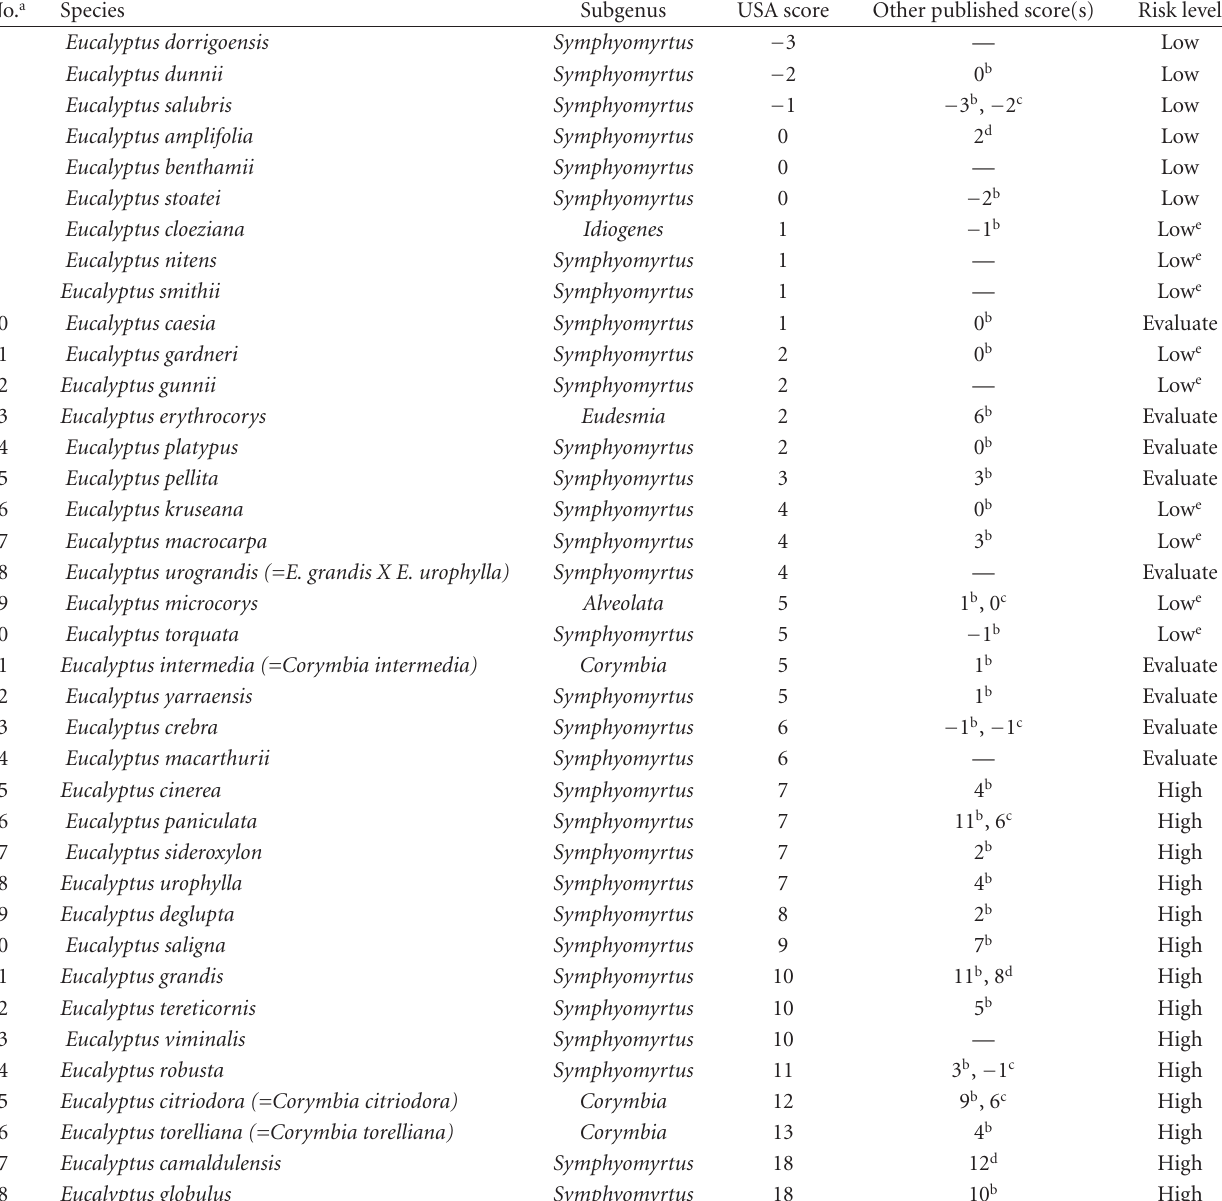
a The taxon number corresponds to the number on the bars in Figure 1.